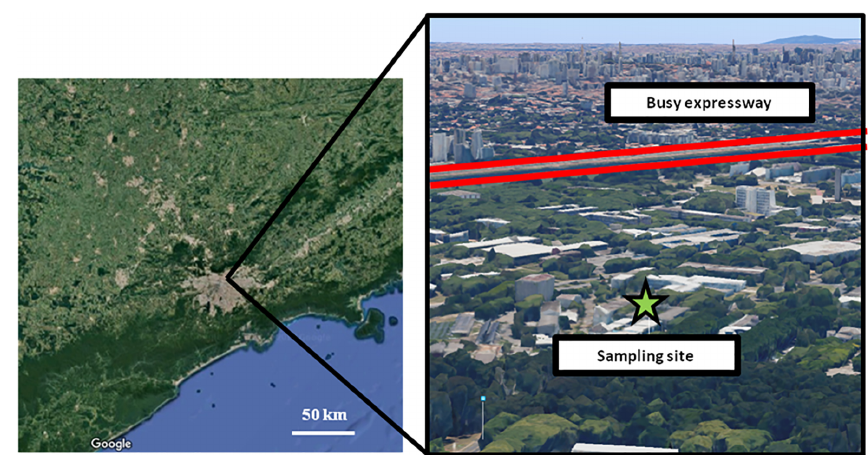
Figure 1. Location of the sampling site. Maps are a courtesy of Google